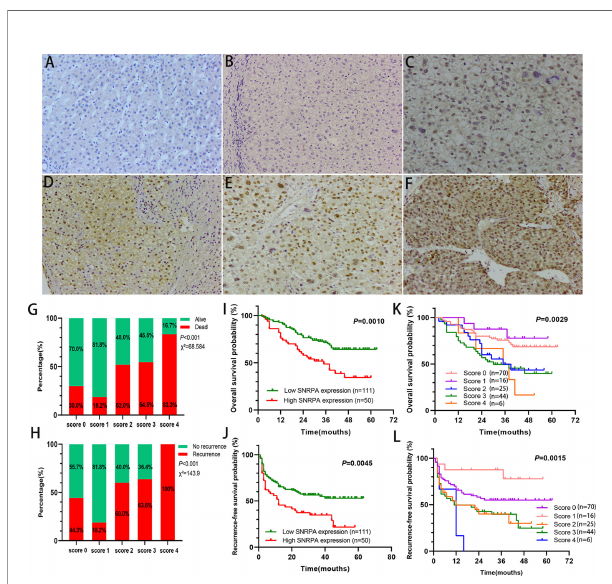
FIGURE 2 | SNRPA protein levels in normal liver tissues and HCC tissues and its prognostic value. (A) Representative images of SNRPA IHC staining for normal liver tissues. (B – F) Representative images of SNRPA IHC staining for score of 0 (B) , 1 (C) , 2 (D) , 3 (E) , and 4 (F) , respectively in HCC tissues. (G) The percentage of alive and death in patients with different SNRPA IHC staining score. (H) The percentage of recurrence in patients with different SNRPA IHC staining score. (I – J) Higher SNRPA protein expression was associated with worse OS (I) and RFS (J) . (K, L) Kaplan – Meier curves of OS (K) and RFS (L) among patients with the different SNRPA IHC staining